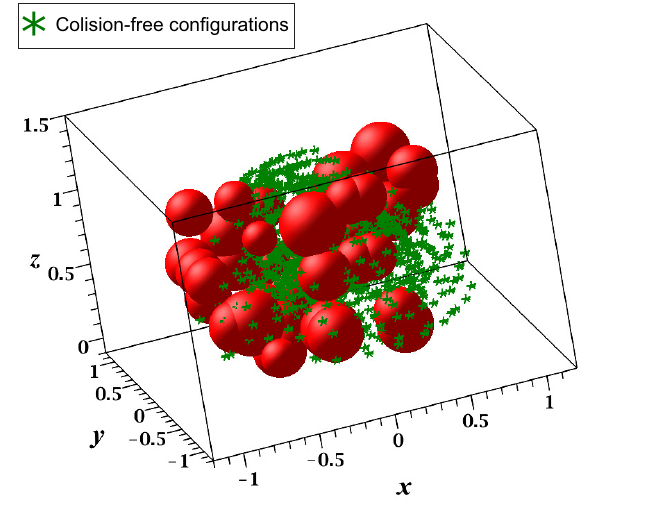
Figure 19. Configuration space of the KUKA manipulator (MapleSoft visualization).